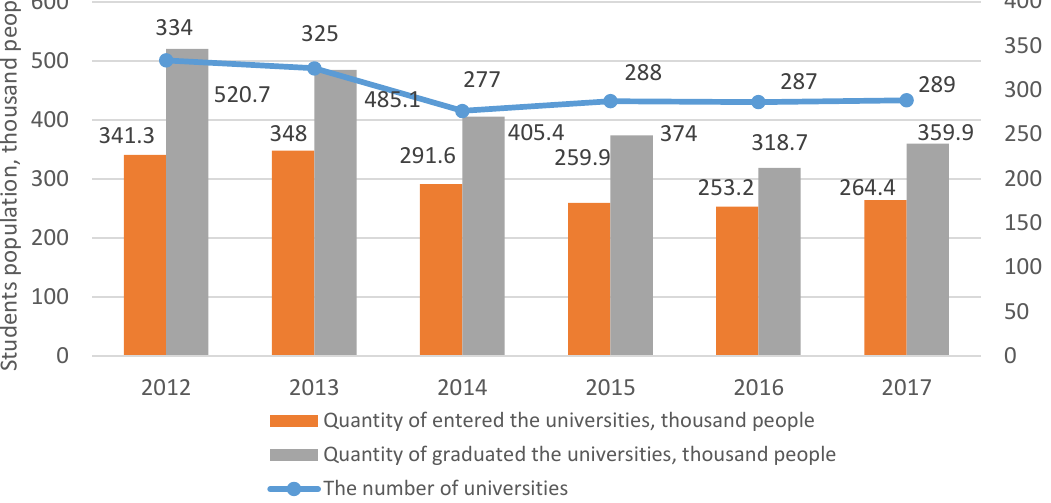
Figure 2. The enrolment and graduation numbers In Higher Educational Institutions in Ukraine during the period